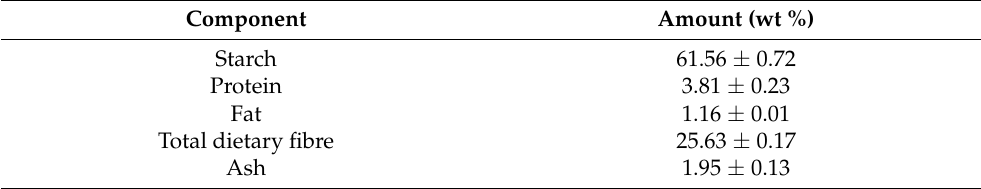
Table 1. Composition of sweet potato residue (g/100 g, dry weight) *.